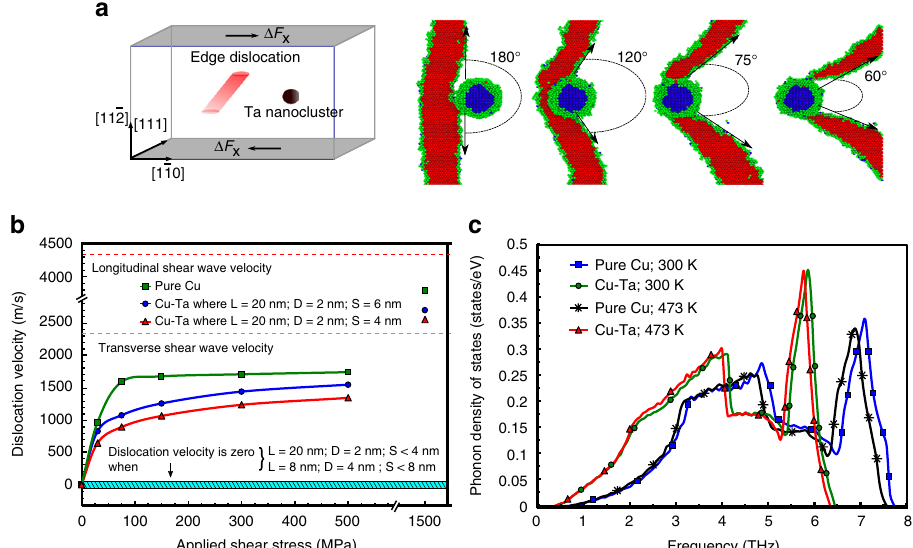
Fig. 4 Atomistic simulation of dislocation interaction with a Ta nanocluster. a A schematic of the simulation of the interaction between an edge dislocation (cid:4) (cid:5) and a Ta nanocluster in a single Cu nanocrystal where X , Y , and Z correspond to the 1 (cid:1) 10 ½ (cid:3) , [111], and 11 (cid:1) 2 directions, respectively, and atomistic simulation results showing an edge dislocation interacting with a Ta nanocluster in a Cu nanocrystal. The red atoms represent the stacking fault region of the dislocation in Cu, the blue atoms represent the Ta nanocluster, and the green atoms represent the boundaries of the crystalline Cu atoms. b Dislocation velocity as a function of applied shear stress for an edge dislocation in nanocrystalline Cu both with and without an embedded Ta nanocluster for 100 K. Here, L is the dislocation line length, D is the diameter of the Ta nanocluster, and S is the distance between the dislocation and Ta nanocluster. Note that for 300 K, the dislocation is instantaneously pinned by the nanocluster at values of S up to 6 nm without any externally applied stresses. c Comparison of phonon density of states for pure Cu and Cu embedded with a Ta nanocluster at both 300 and 473